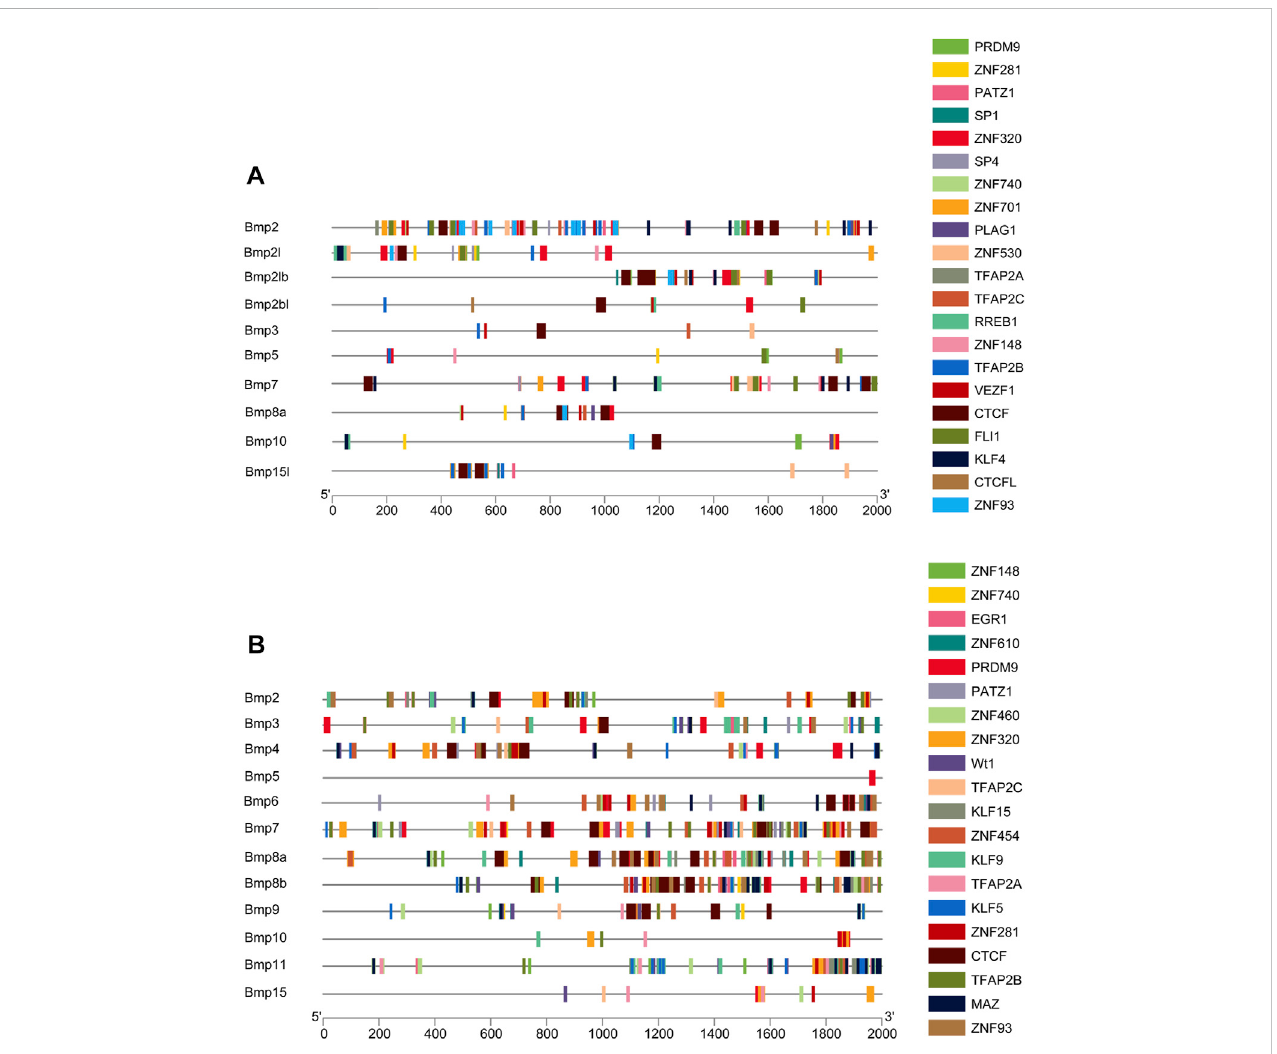
FIGURE 9 Promoter analysis of BMP genes in P . sinensis (A) and Homo (B) . Different colored rectangles indicate different transcription